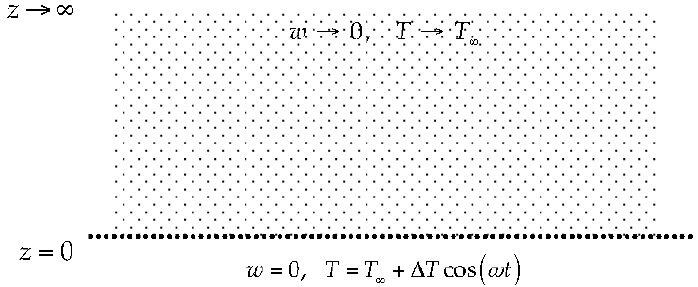
Figure 1. Depicting the semi-infinite porous medium and the imposed boundary conditions.